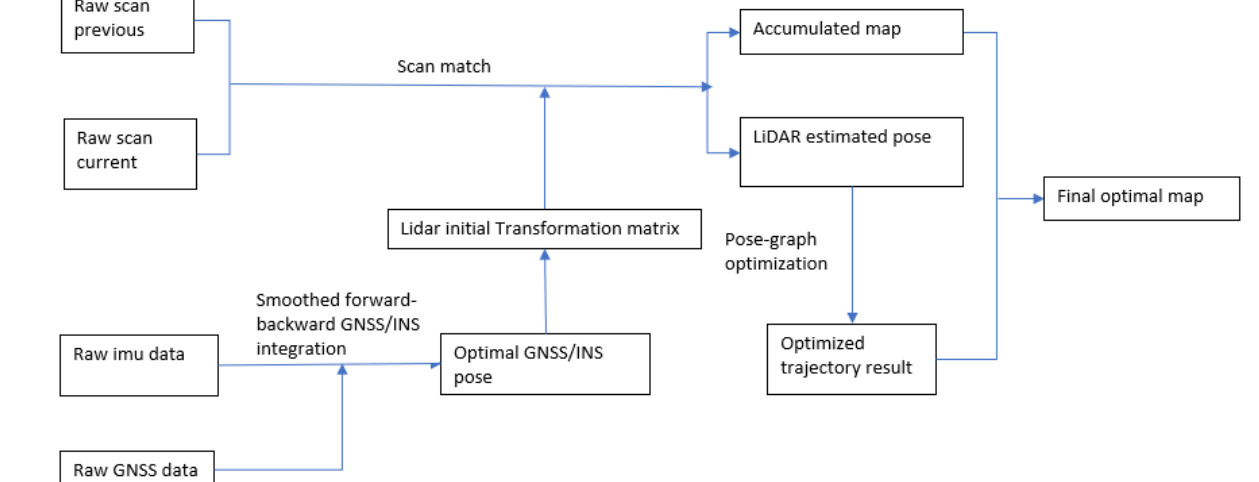
Figure 7. Overview of the Lidar/GNSS/INS mapping system architecture.